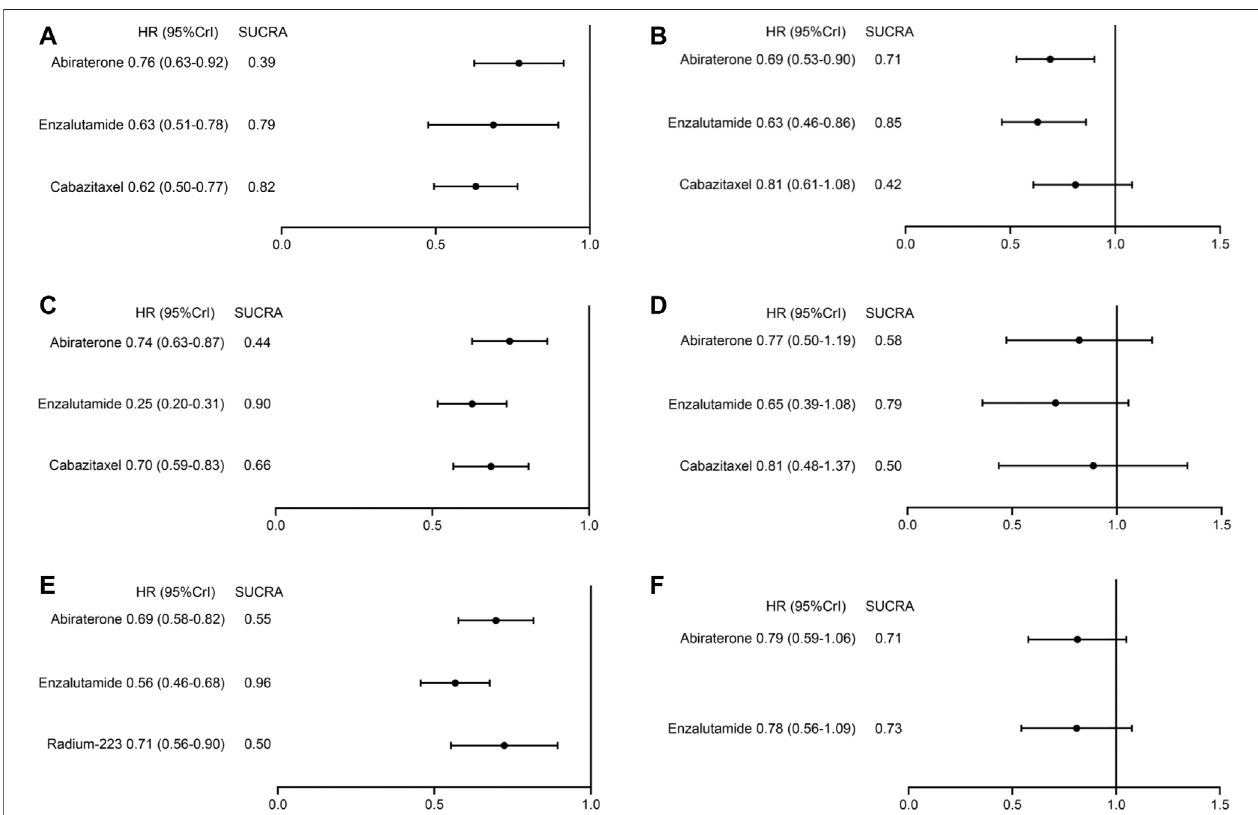
FIGURE 4 | Treatment ranking and relative effects of systemic treatments from subgroup analyses on overall survival. (A) patient age ≥ 65 years, (B) patient age < 65 years, (C) patients with an ECOG score < 2, (D) patients with a ECOG score ≥ 2, (E) patients without visceral metastases, (F) patients with visceral metastases.